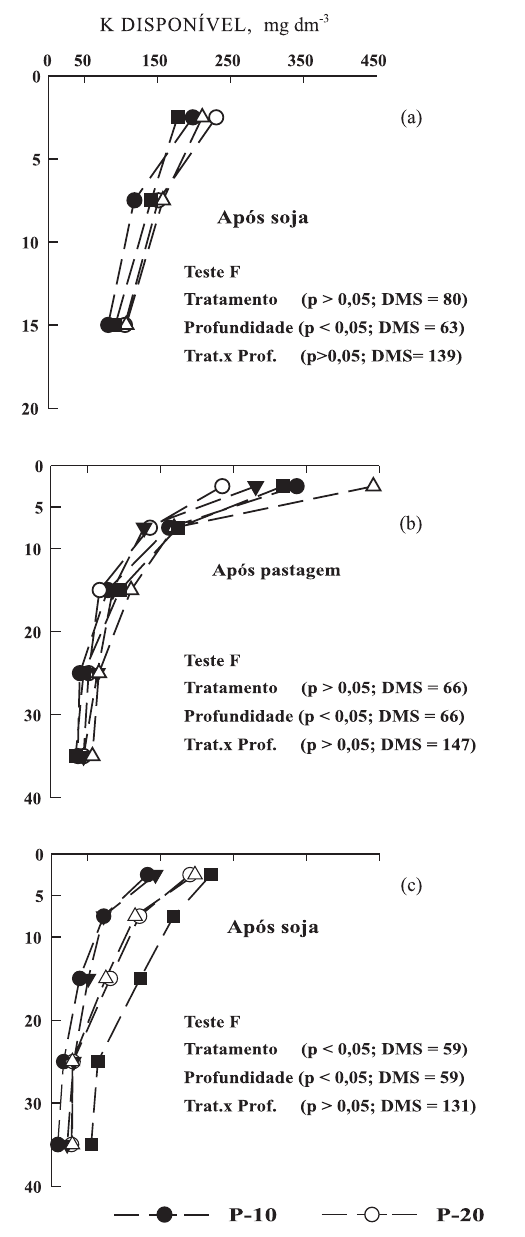
Figura 3. Teores de potássio disponível (Mehlich-1) e de C orgânico em diferentes profundidades do solo em função de diferentes intensidades de pastejo (10, 20, 30 e 40 cm de altura do pasto - P-10, P-20, P-30 e P- 40, respectivamente) e sem pastejo (SP), em (a, d) maio de 2007, (b, e) novembro de 2007 e (c, f) maio de 2008. Trat.: tratamento; Prof.: profundidade; DMS: diferença mínima significativa pelo teste de Tukey a 5